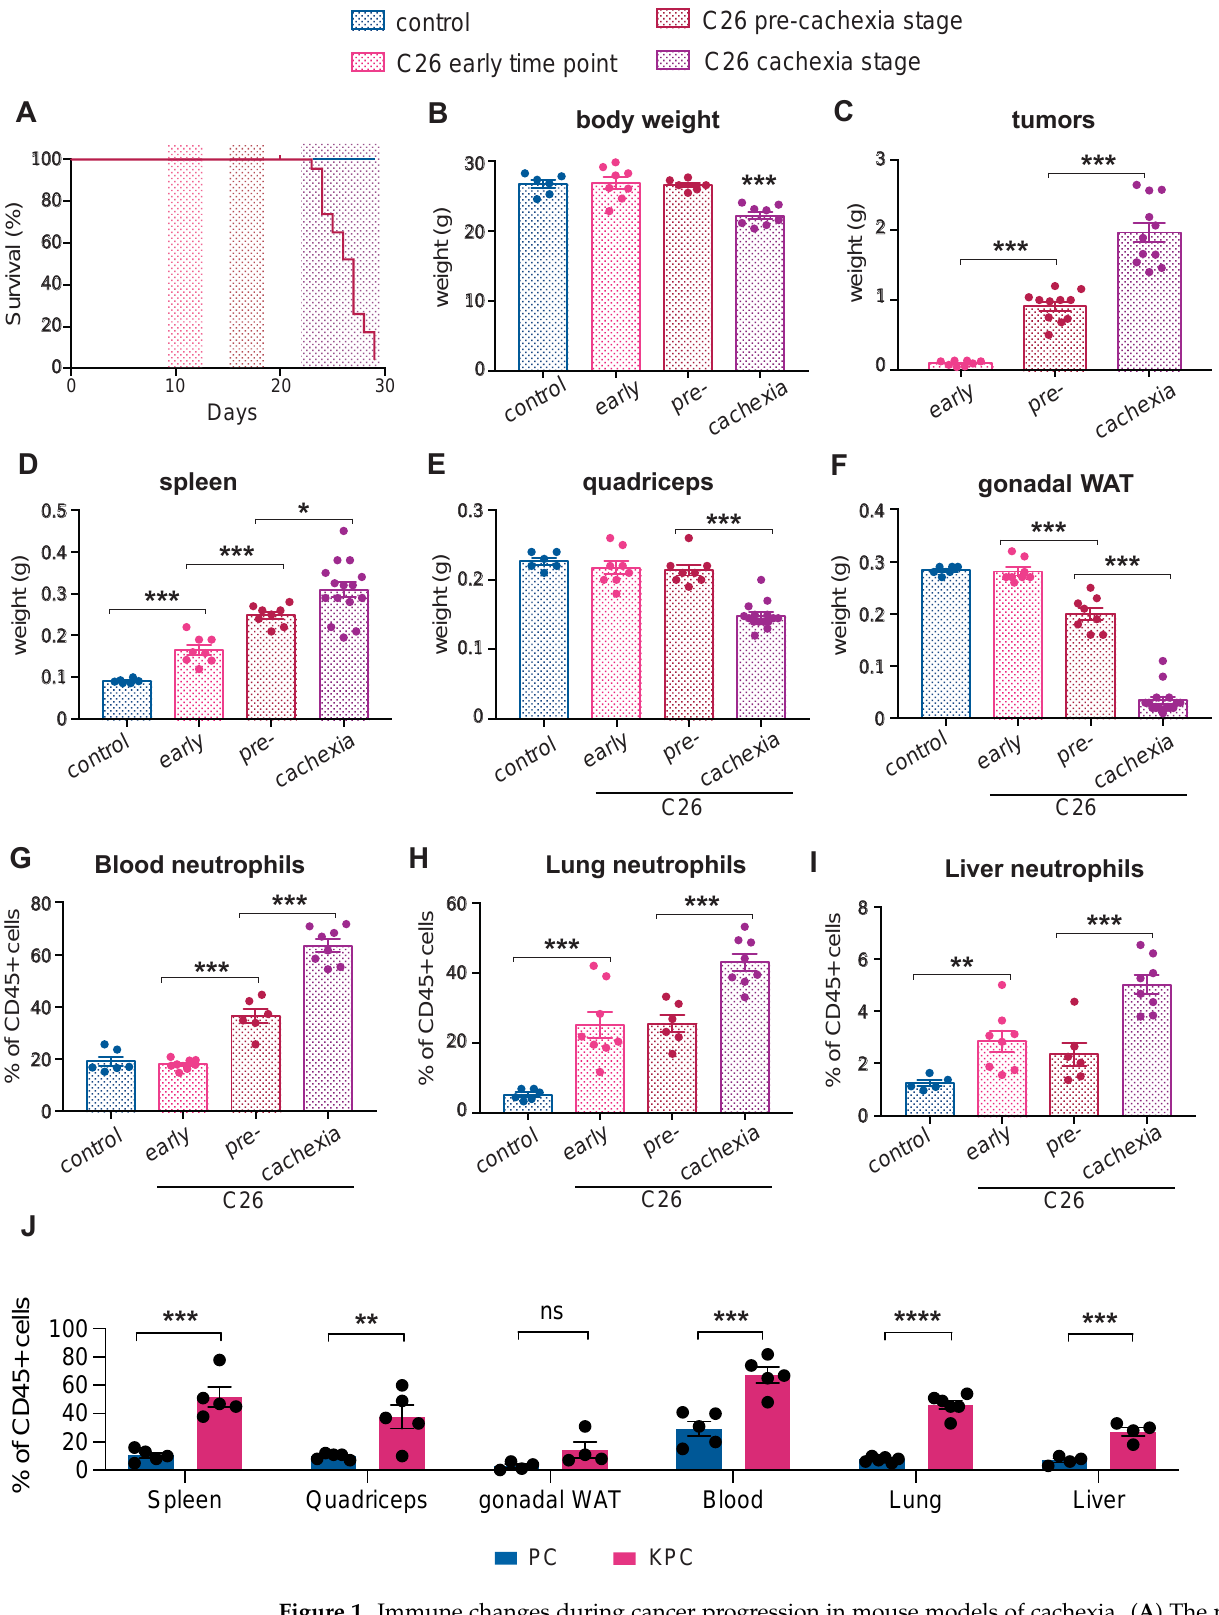
Figure 1. Immune changes during cancer progression in mouse models of cachexia. ( A ) The mice were injected with C26 colorectal cancer cells and sacrificed at three distinct time points: an early time point (9–10 days post-tumor inoculation), the pre-cachectic stage (15–16 days post-injection), and when cachexia occurred (≥21 days post-injection); ( B – F ) The body ( B ), tumor ( C ), spleen ( D ), quadriceps ( E ), and gonadal white adipose tissue (gWAT) ( F ) weights of mice that were sacrificed at the time points that are defined in Figure 1A; ( G – I ) Quantification of neutrophils (displayed as % of neutrophils out of all CD45+ cells), by flow cytometry in the blood ( G ), lung ( H ), and liver ( I ) of mice that were sacrificed at the time points that are defined in Figure 1A; ( J ) Quantification of neu- trophils (displayed as % of neutrophils out of all CD45+ cells) in the spleen, quadriceps, gWAT, blood, lung, and liver of pre-cachectic KPC mice and the PC controls. The data are expressed as the mean ± SEM. A one-way ANOVA with Tukey’s correction for post hoc testing was used in ( B – I ). Statistical differences in ( J ) were examined using unpaired two-tailed Student’s t -test with Welch’s